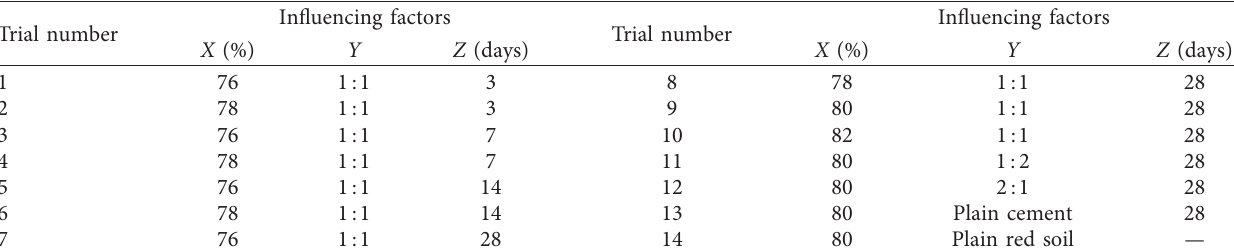
Figure 4: XRD diffraction pattern of cement. Table 6: Table of test factors and